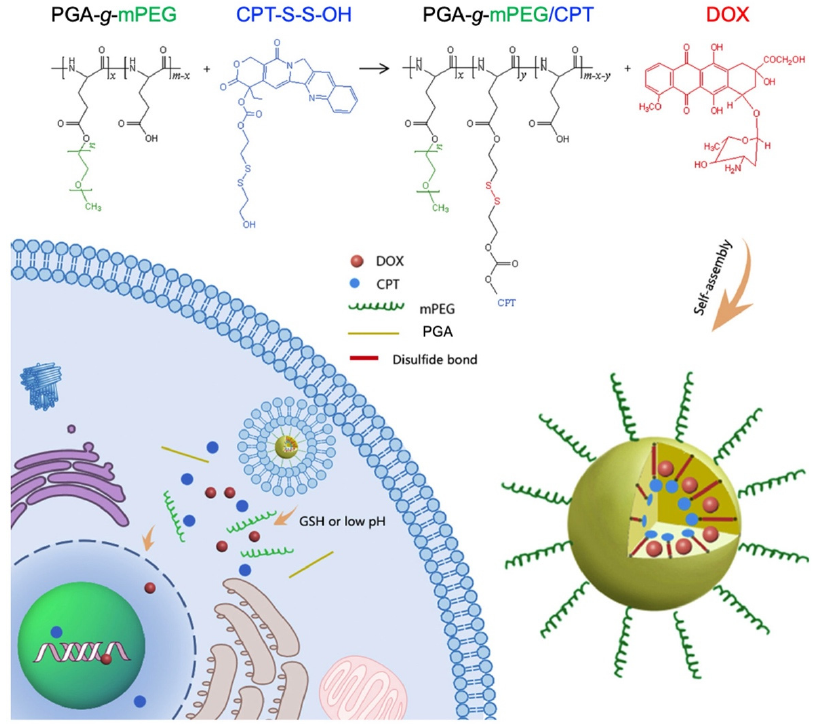
Figure 4. Construction of PGA– g –mPEG-based CPT conjugate and its encapsulation of DOX for GSH-triggered dual drug release in cancer cells. Reprinted with permission from Ref. [77]. Copyright 2018, Elsevier.